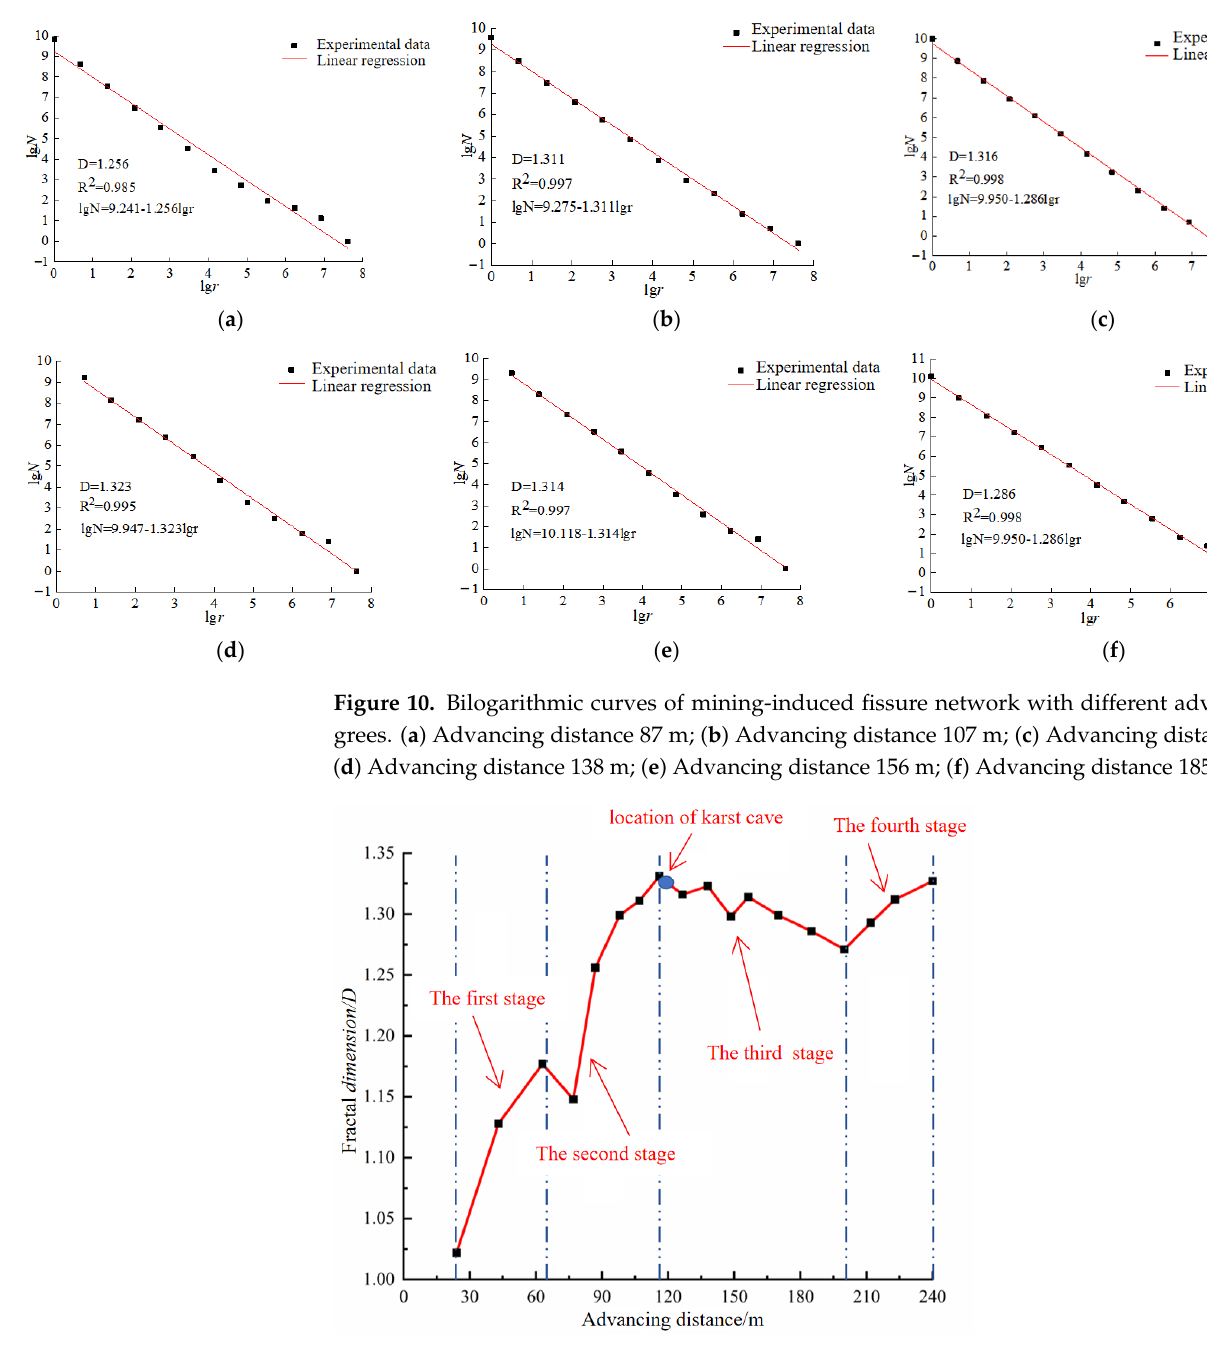
Figure 11. Variation curve of fractal dimension.